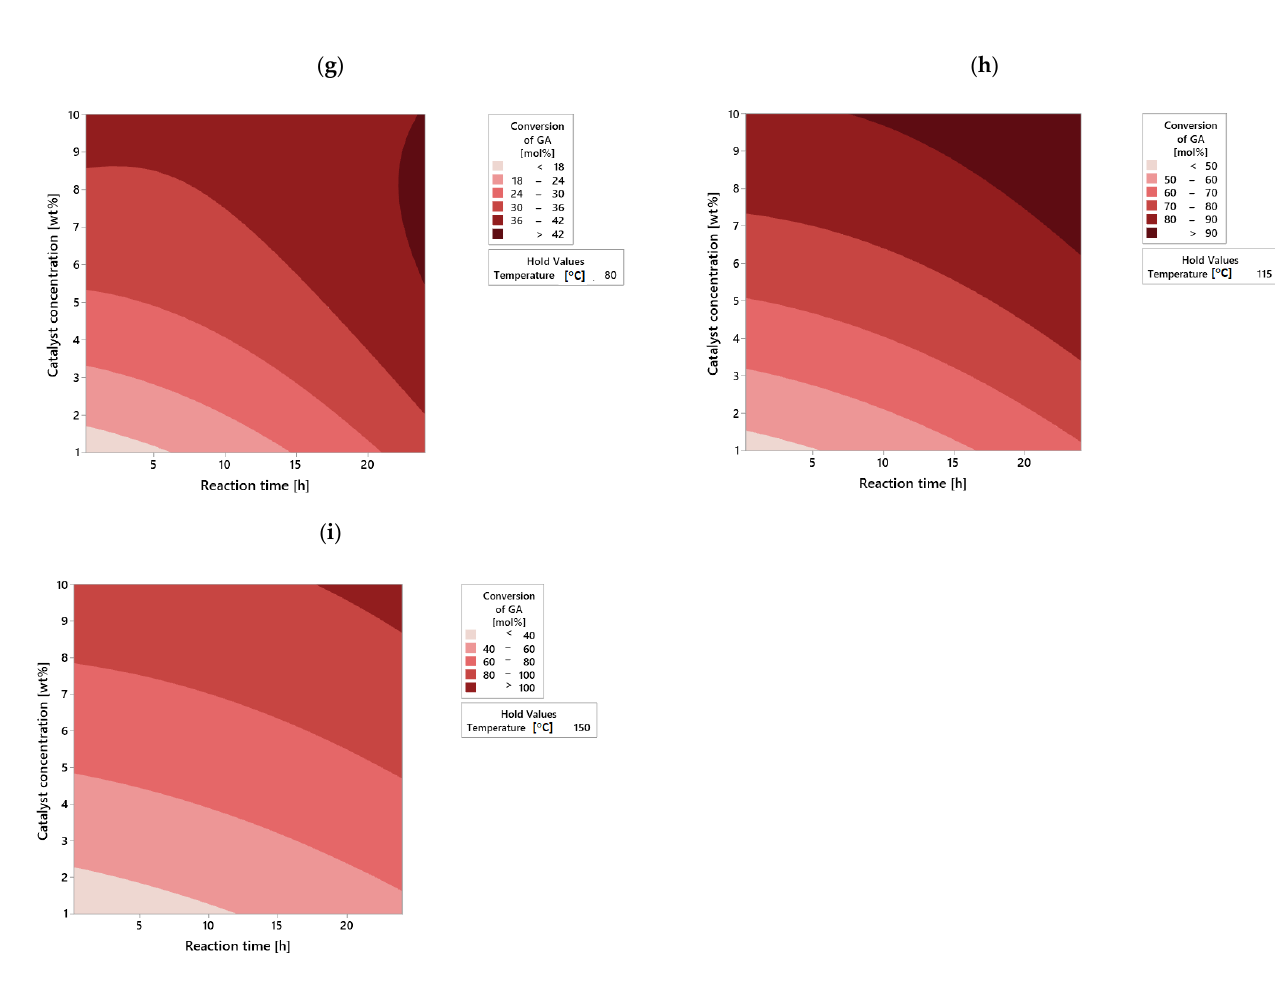
Figure 8. The influence of transformation process parameters on geraniol conversion (C GA ) at: time: Figure 8. The in fl uence of transformation process parameters on geraniol conversion (C GA ). ( a ) 0.25 h, ( b ) 12.125 h, and ( c ) 24 h, concentration: ( d ) 1 wt%, ( e ) 5.5 wt%, and ( f ) 10 wt%, and temperature: ( g ) 80 ◦ C, ( h ) 115 ◦ C and ( i ) 150 ◦